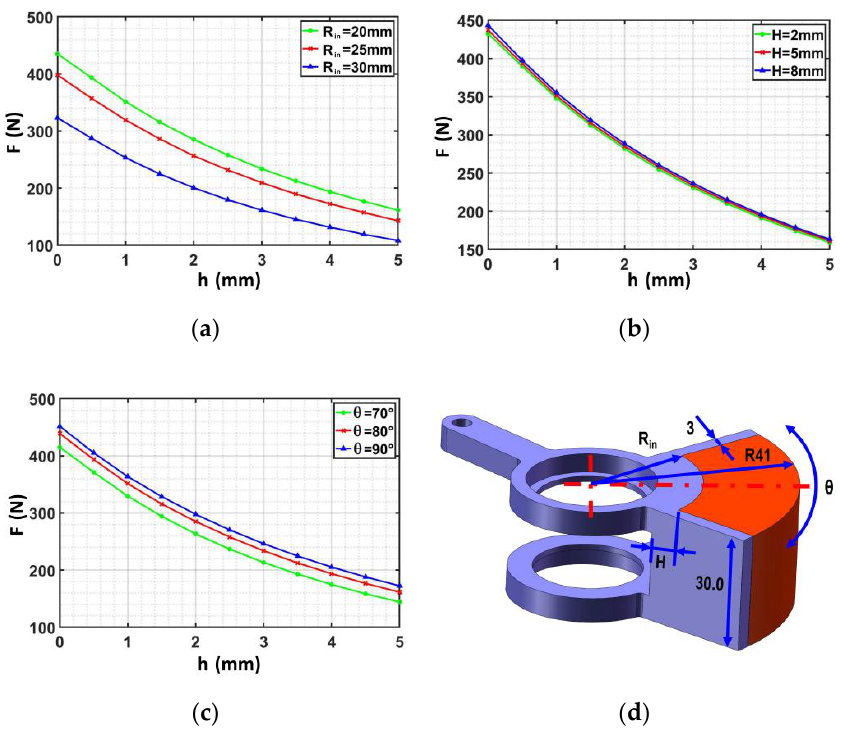
Figure 3. Influence of magnetic wheel parameters on the adsorption force: ( a ) The relationship between the adsorption force and the air gap height under different inner radius of the magnet, ( b ) the relationship between the adsorption force and the air gap height under different yoke iron thicknesses, ( c ) the relationship between the adsorption force and the air gap height under different magnet center angles, and ( d ) description of magnetic wheel structure and size.